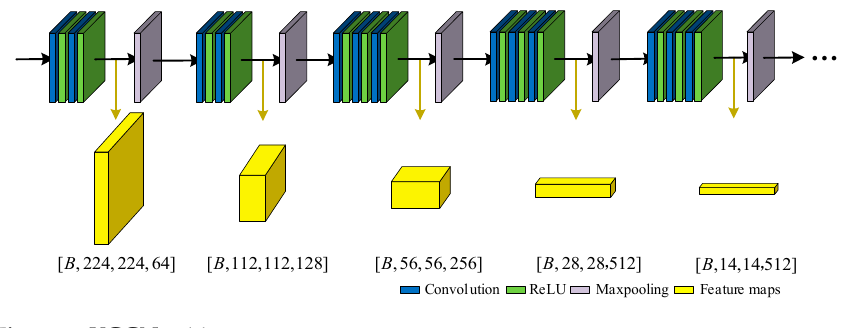
Figure 3. VGGNet-16. Figure 3.